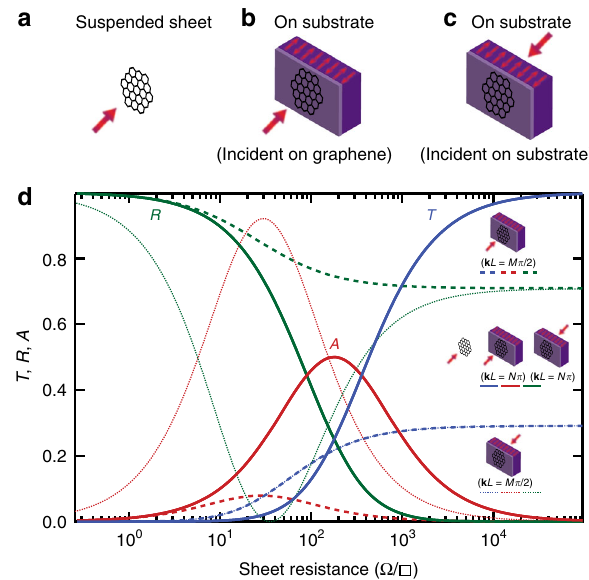
Fig. 2 Transmission, re fl ection and absorption. a – c A suspended fi lm and a fi lm on a substrate for two incidence directions were analyzed using the transmission line model. n = 3.41 was used as the substrate index of refraction for calculation. d The suspended fi lm/Woltersdorff equations (plotted as solid lines) for T , R and A vs. sheet resistance were compared to a fi lm on a substrate. When the half-wave resonance condition is satis fi ed ( k L = N π , where N is an integer), the equations for T , R and A reduce to exactly the Woltersdorff equations (plotted for both directions as solid lines, and are indistinguishable from the suspended fi lm). Hence, analyzing the device at half-wave resonance provides a direct comparison of the graphene absorption on a substrate to that of a suspended fi lm. At quarter- wave resonance ( k L = M π /2, where M is an odd integer), T is the same for both incidence directions, but R and A are different for each incidence direction (plotted as the dotted